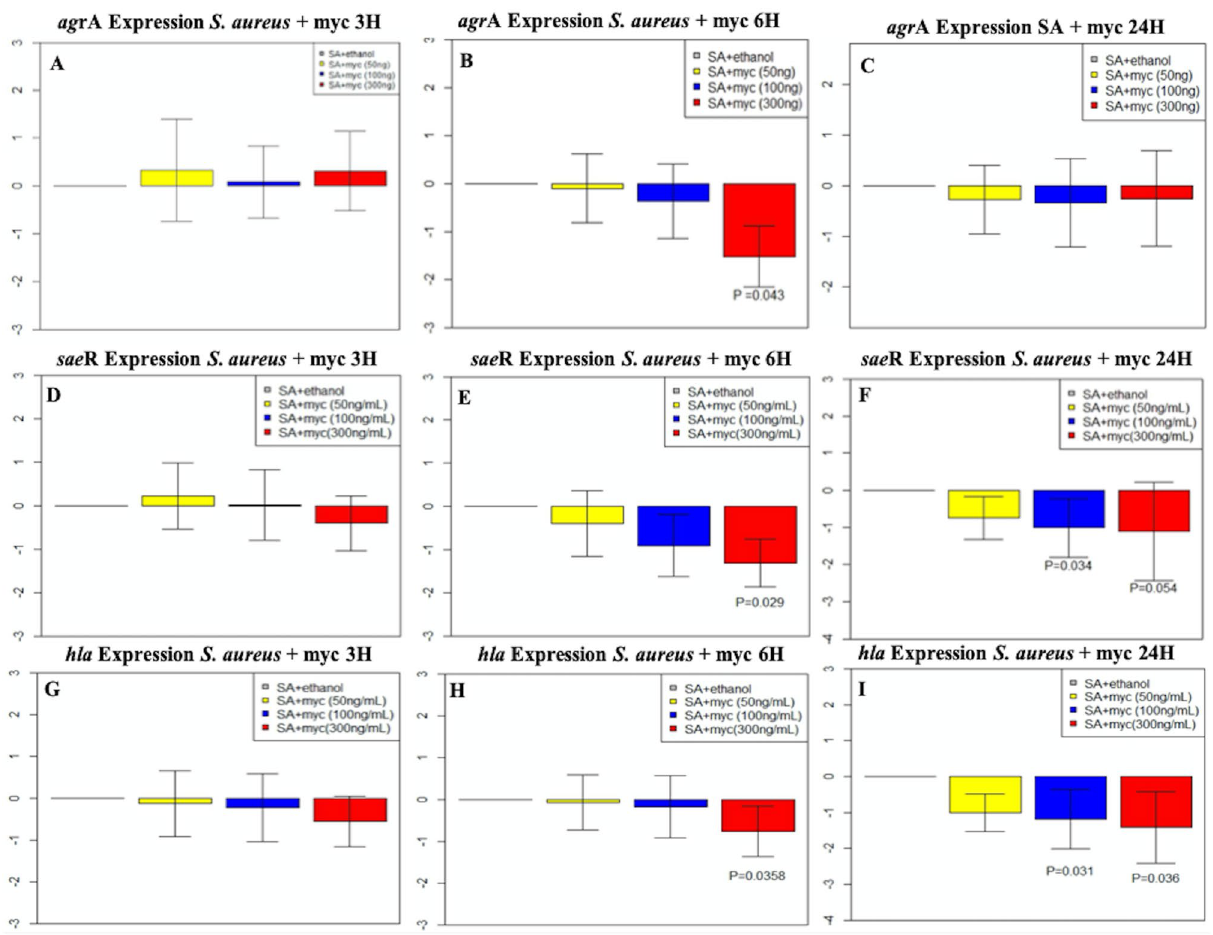
Figure 3. Gene expression of S . aureus agr A, saeR , and hla when exposed to 50, 100, or 300 ng mycolactone concentrations over time. ( A – C ) agr A regulation at 3H, 6H, and 24H, respectively. ( D – F ) sae R regulation at 3H, 6H, and 24H, respectively. ( G – I ) hla expression at 3H, 6H, and 24H respectively. Regulation was measured for all genes against the aroE housekeeping down-regulated genes are shown in Supplemental Table S1. Ninety-two genes were significantly up-regulated and 58 genes were significantly downregulated in response to mycolactone in comparison to control. Three hour timepoint. Forty-four differentially regulated genes were identified at the 3H timepoint. These included 21 downregulated and 23 upregulated genes in the S. aureus -mycolactone treatment compared to con- trol. Fourteen genes associated with metabolism were differentially regulated (Fig. 5). For instance, a thioredoxin reductase ( trxB ), involved in amino acid metabolism was downregulated, while two genes for arginine biosyn- thesis ( argG and argH ) were upregulated. One gene fakb2 , was upregulated, and involved in lipid metabolism. Three genes involved in metabolism of cofactors/vitamins were upregulated including genes involved in folate ( dfrA ), thiamine ( thiD ), and vitamin B6 ( pdxS ) metabolism. Carbohydrate metabolism was modulated where two genes, adhE and adhP , encoding for alcohol dehydrogenase were downregulated as was one gene for l-lactate dehydrogenase (LDH). The ulaB gene, encoding the PTS lactose transporter subunit IIB, was upregulated. Three genes for energy metabolism were downregulated including qoxA , qoxB , and qoxC, genes for probable quinol oxidase subunits. However, nitrate reductase beta chain narH , involved in nitrogen metabolism, was upregulated (Fig. 5). Twelve genes involved in genetic information processing were downregulated at the 3H timepoint (Fig. 5). These included 7 genes involved in mechanistic components of translation, one for transcription, and three transcriptional regulators including the transcriptional activator sarR , a negative regulator of sarA transcription and positive regulator of expression of primary transcripts RNAII and RNAIII generated by the Agr locus. Genes encoding a universal stress protein ( uspA ) and a cold shock protein ( cspC ), along with the preprotein translocase subunit secY were also downregulated. Among those upregulated within the genetic information processing category included the transcriptional activator, rinB , gtfB, encoding a stabilizing protein that is part of the acces- sory SecA2/SecY2 system, the repair gene recR , and 8 genes involved in mechanistic components of translation. Genes encoding a probable potassium-transporting ATPase B chain gene ( kdpB ) and a glutamine ABC trans- porter ATP-binding protein ( glnQ ), both involved in environmental information processing were upregulated.